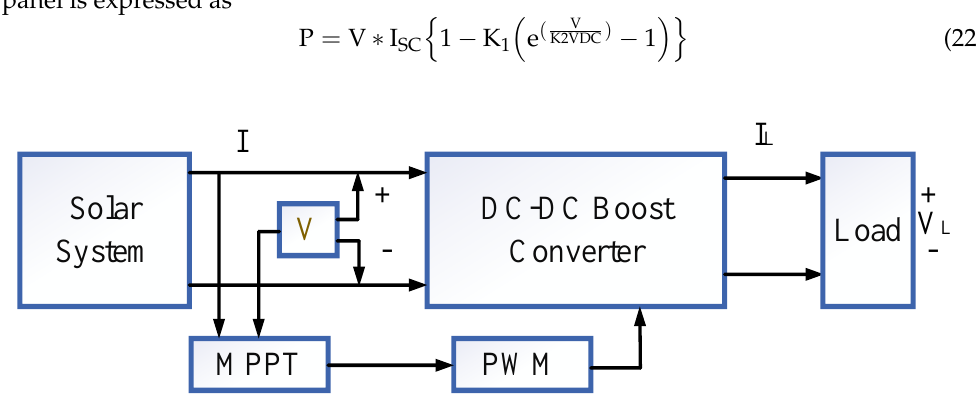
Figure 11. Block Diagram for PV System.